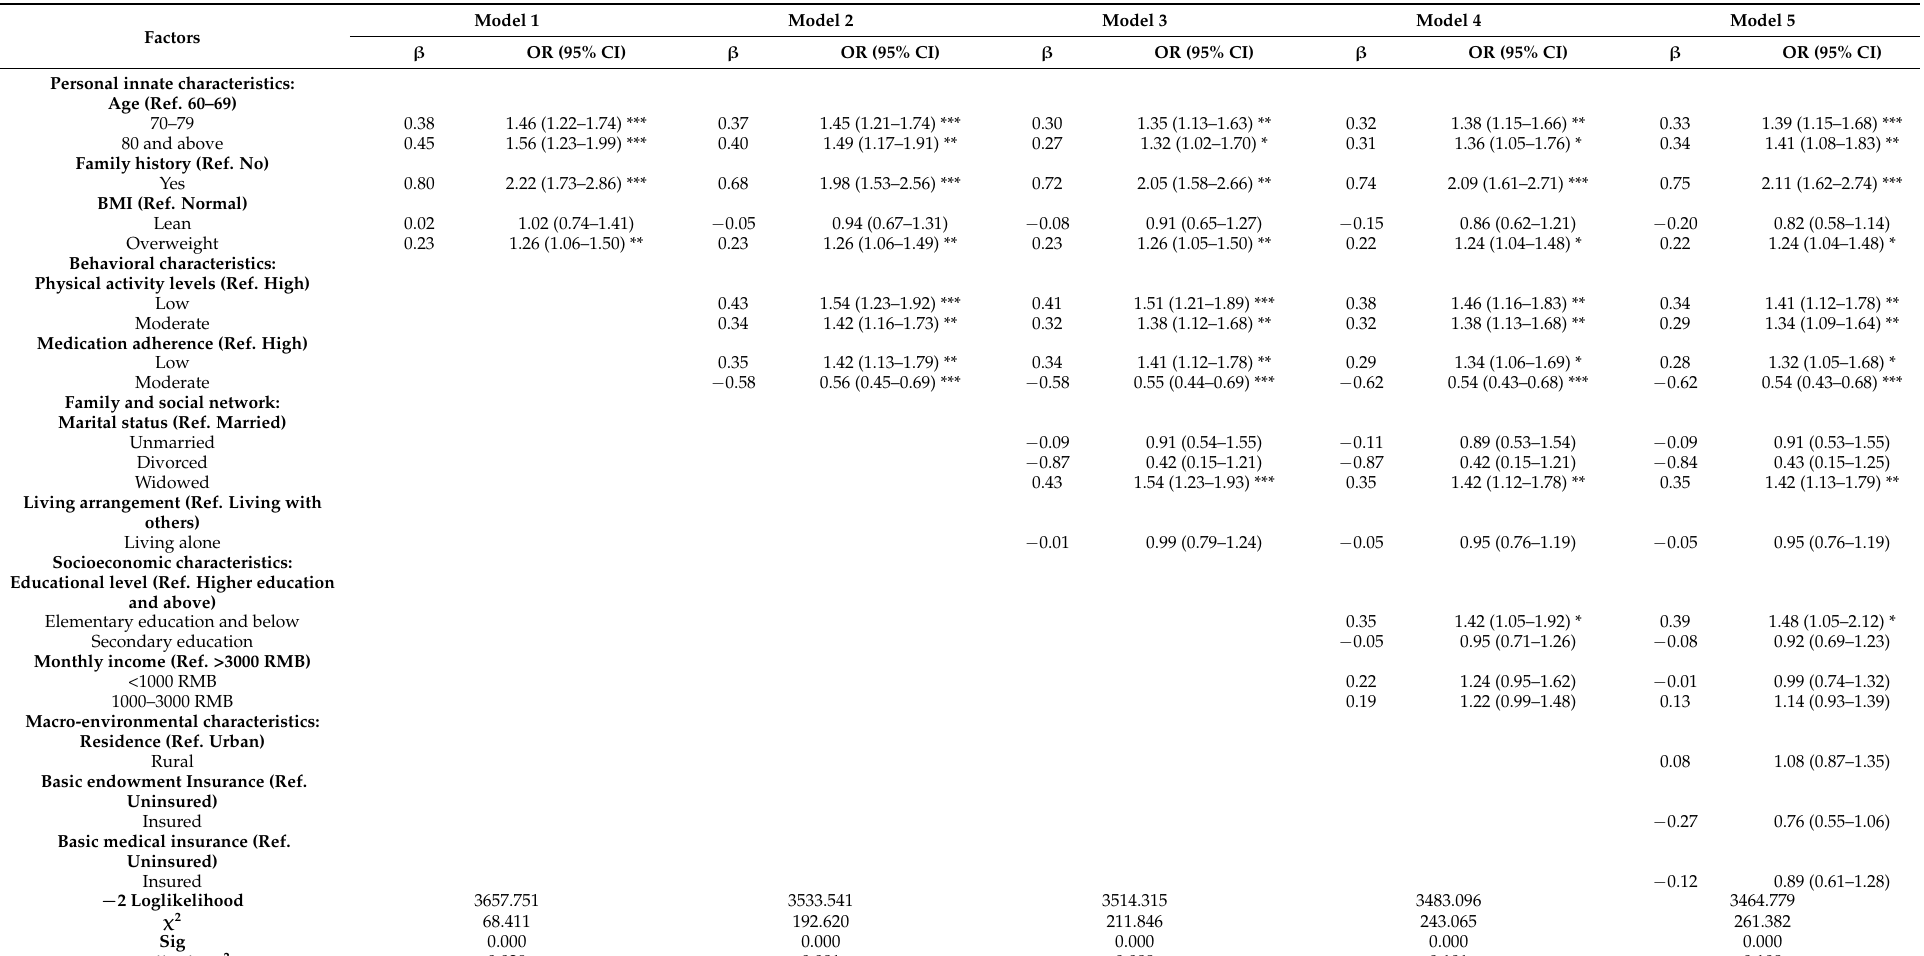
Table 4. Hierarchical multiple logistics regression analysis of multi-layer factors related to